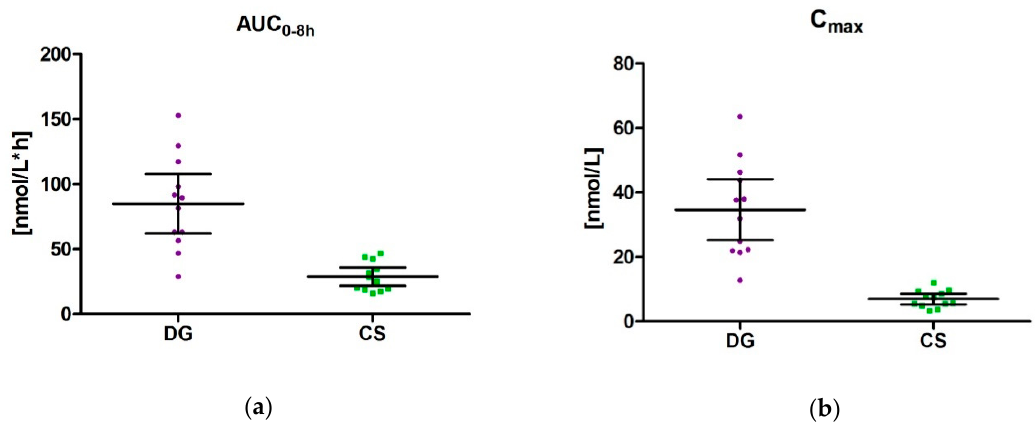
Figure 3. Scatter chart with pharmacokinetic endpoints calculated from individual concentration time curves after intake of maqui berry extract; mean ± 95% CI: ( a ) AUC 0–8 h [nmol/L*h] ( b ) C max [nmol/L]; DG: delphinidin-3- O -glucoside; CS: cyanidin-3- O -sambubioside.